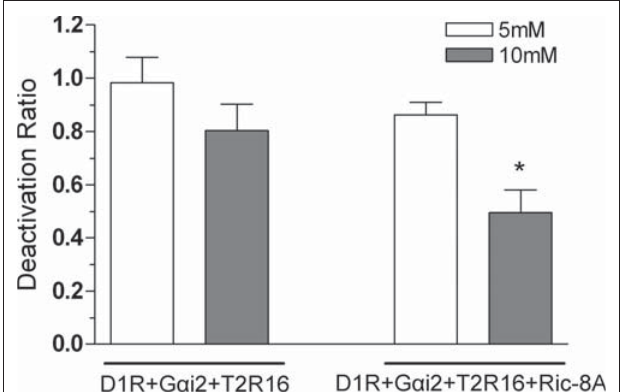
FIGURE 5 | Ric-8A enhances G α i2 mediated decreases in cAMP concentration. Production of cAMP was measured in HEK 293T cells transfected with D1R, Tas2R16, G α i2 with or without Ric-8A in the presence of 10 µM dopamine, or 10 µM dopamine plus 5 (white bars) or 10 mM (grey bars) salicin as indicated. The graph shows the mean and SD values of four independent experiments. The deactivation ratio is calculated by dividing values after a dopamine + salicin stimulation by the corresponding dopamine activation values. For 10 mM salicin Ric-8A enhancement of G α i2 mediated deactivation was statistically signifi cant. (*) p < 0.05, Paired Student’s t -test.